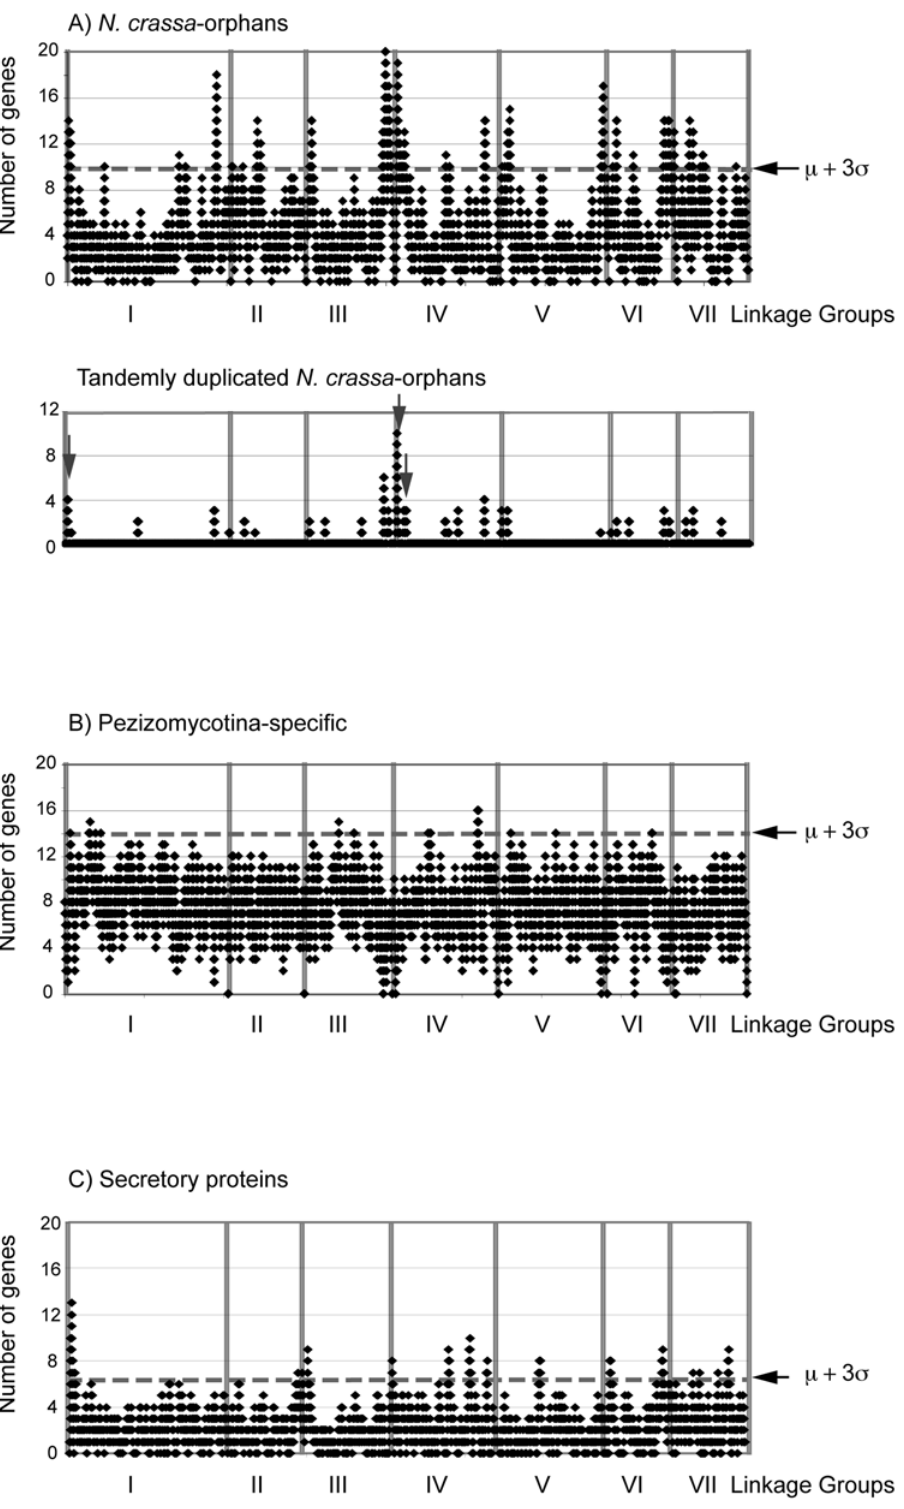
Figure 4. Distribution of A) N.crassa -orphan, B) Pezizomycotina-specific and C) secretory PCGs across the seven chromosomes. Distribution of these gene sets were evaluated for every 20 PCGs along N. crassa chromosomes I to VII. The chromosomal distribution of tandemly duplicated N. crassa -orphan PCGs is shown at the lower panel in A). The vertical grey arrows indicate clusters of five or more gene paralogs. Boundaries between chromosomes are shown with vertical lines. A mean density + 3 standard deviations (p=0.001) according to binomial distribution is shown with a horizontal black arrow in each panel.